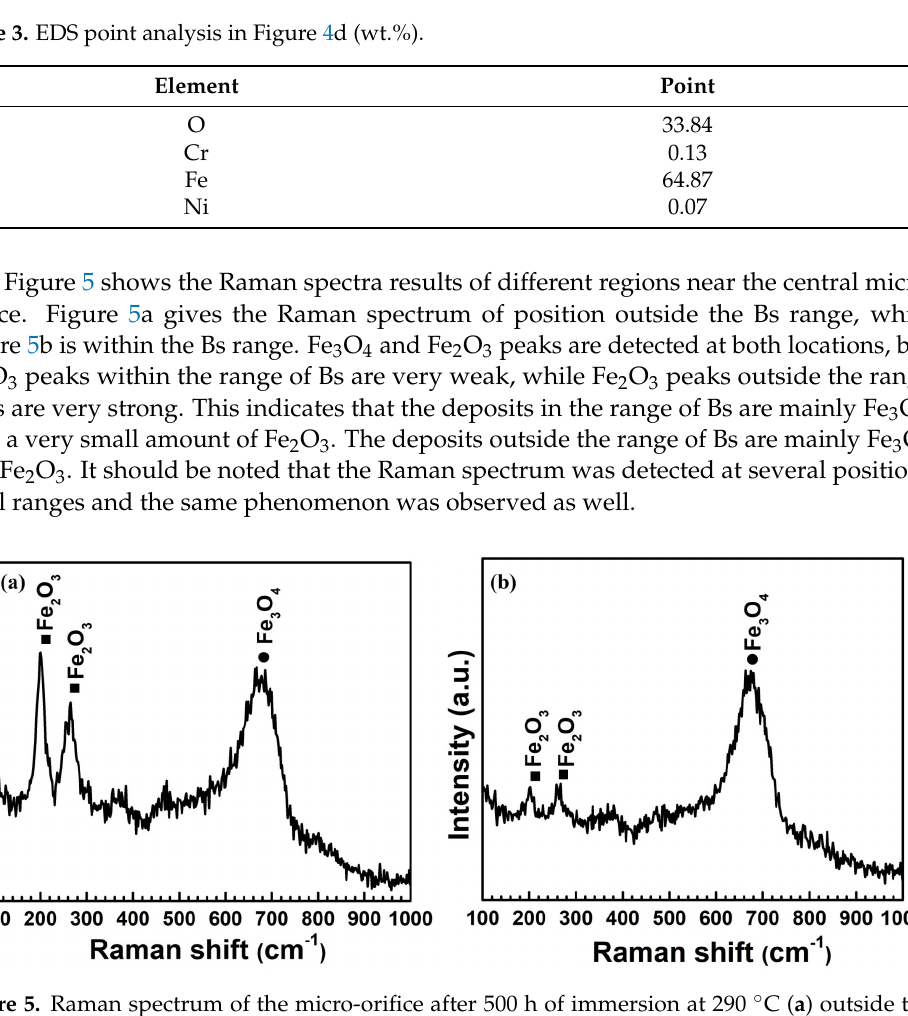
Figure 5. Raman spectrum of the micro-orifice after 500 h of immersion at 290 °C ( a ) outside the range of B S and ( b ) in the range of B S.